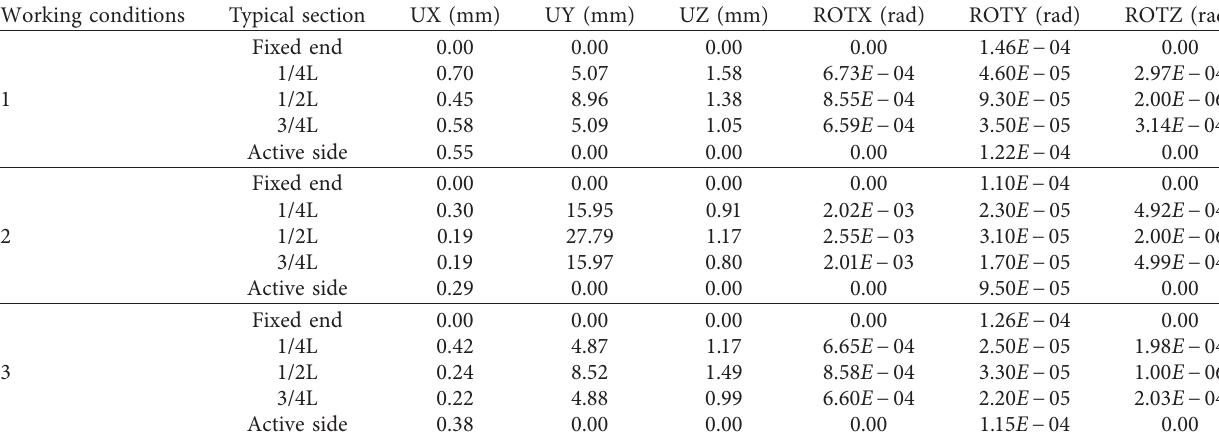
Table 5: The peak values of displacement of the